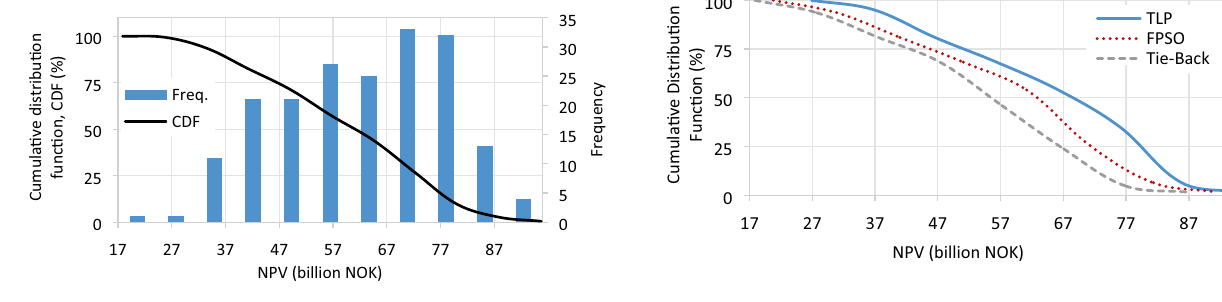
Fig. 12 Comparison of NPV’s cumulative density function for all topside